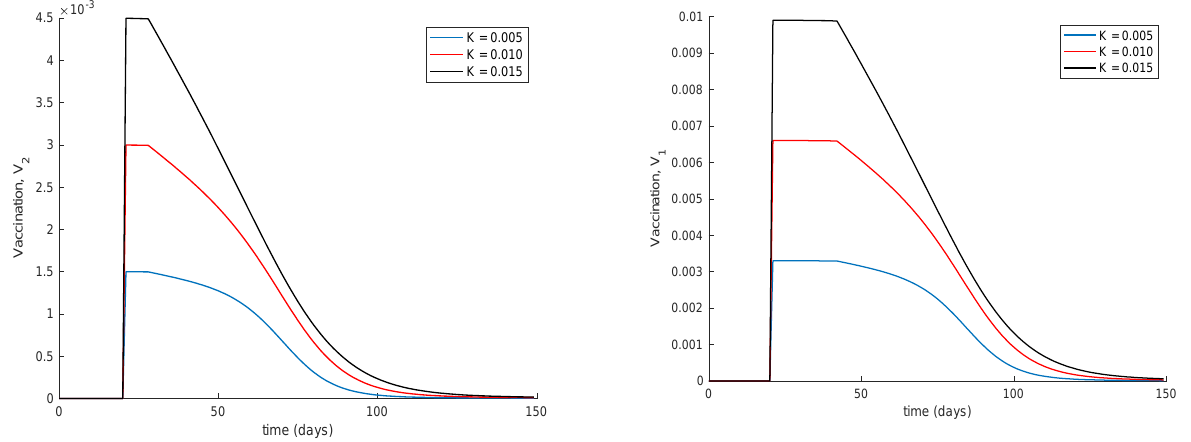
Figure 6. Vaccination actions for different values of the control gain K .